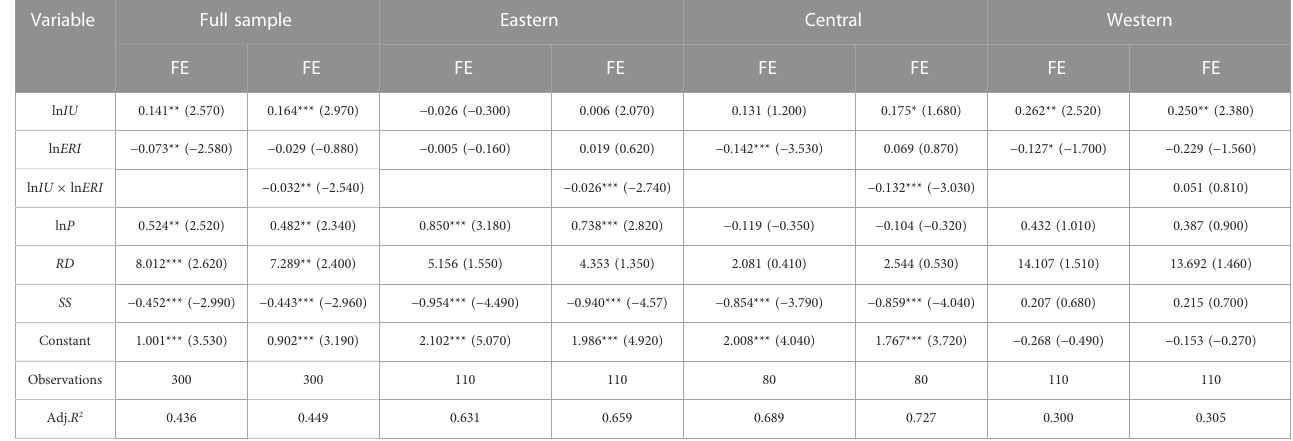
TABLE 5 Regional heterogeneity. Variable